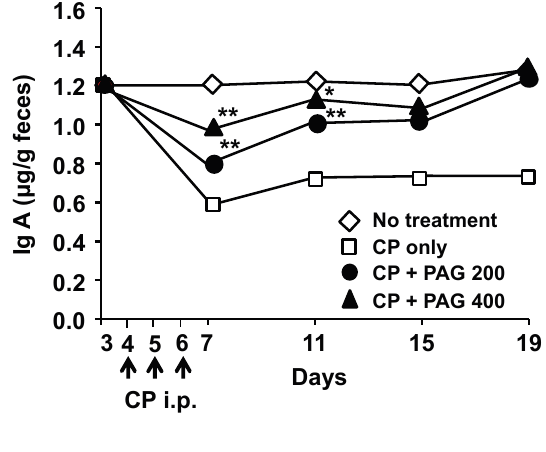
Figure 6. Effect of oral administration of PAG on CP-suppressed IgA production in the intestine. Fresh feces from mice from each group were collected on days 3, 7, 11, 15, and 19. The feces were freeze-dried, weighed, and dissolved in phosphate-buffered saline containing protease inhibitors. Total IgA levels in fecal extracts were assessed by using an ELISA. * indicates p < 0.05 and ** indicates p <